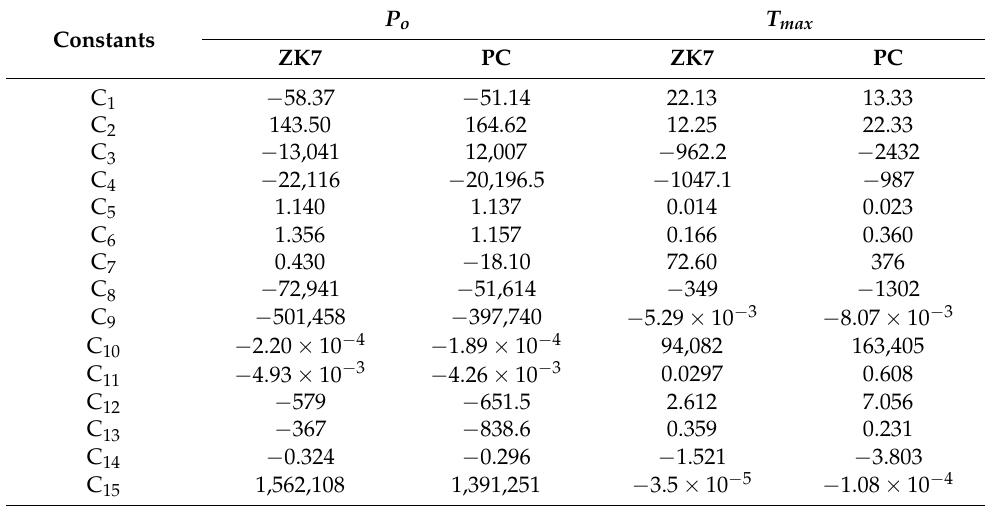
Table 3. Values for the coefficients of Taguchi correlations expressed by Equation